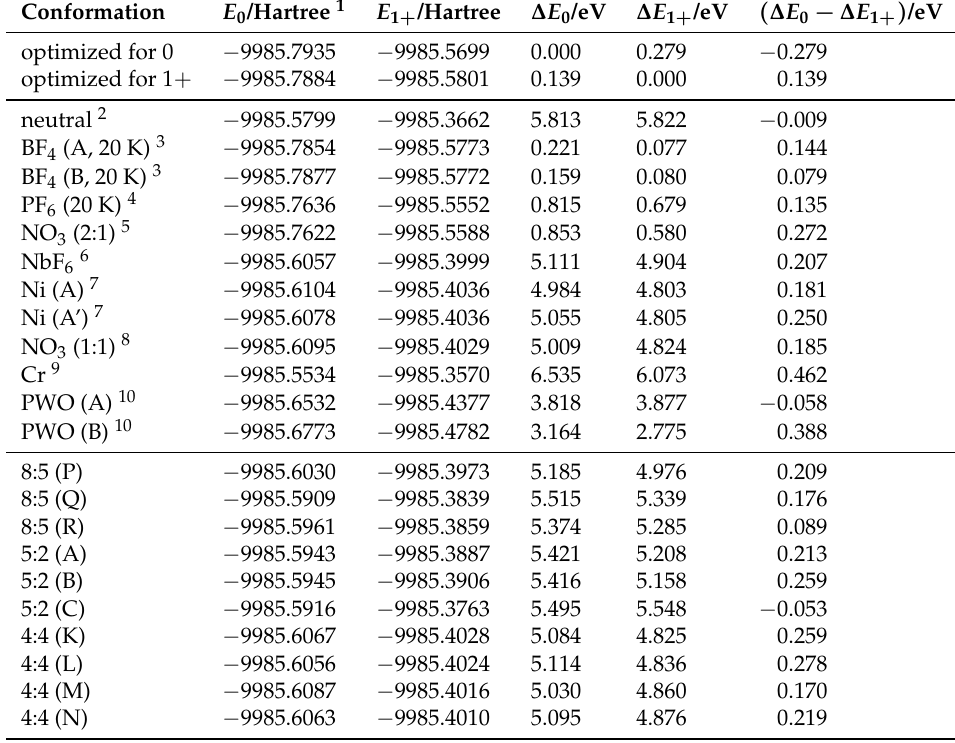
Table 3. The total energies of TMTSF molecules at neutral and cationic states ( E 0 and E 1 + ); their relative values with respect to those calculated for the optimized structures ( ∆ E 0 = E 0 − E 0 ( optimized for 0 ) and ∆ E 1 + = E 1 + − E 1 + ( optimized for 1 +) ); and their difference ( ∆ E 0 − ∆ E 1 + ) as a measure of the valence of each conformation of TMTSF molecule. The calculations of E 0 and E 1 + were carried out on the basis of the density-functional theory (B3LYP, 6-31G(d,p))